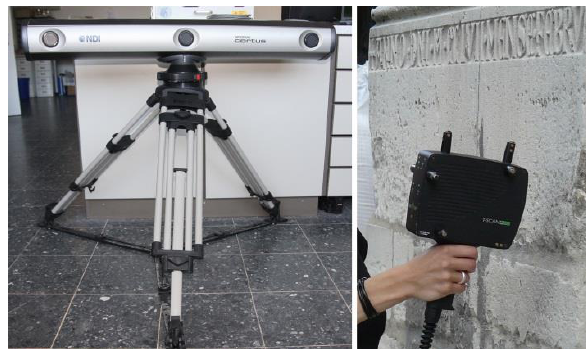
Figure 3. Steinbichler T-Scan 2: Optotrak Tracking system and handheld laser scanner. (Rahrig/Drewello